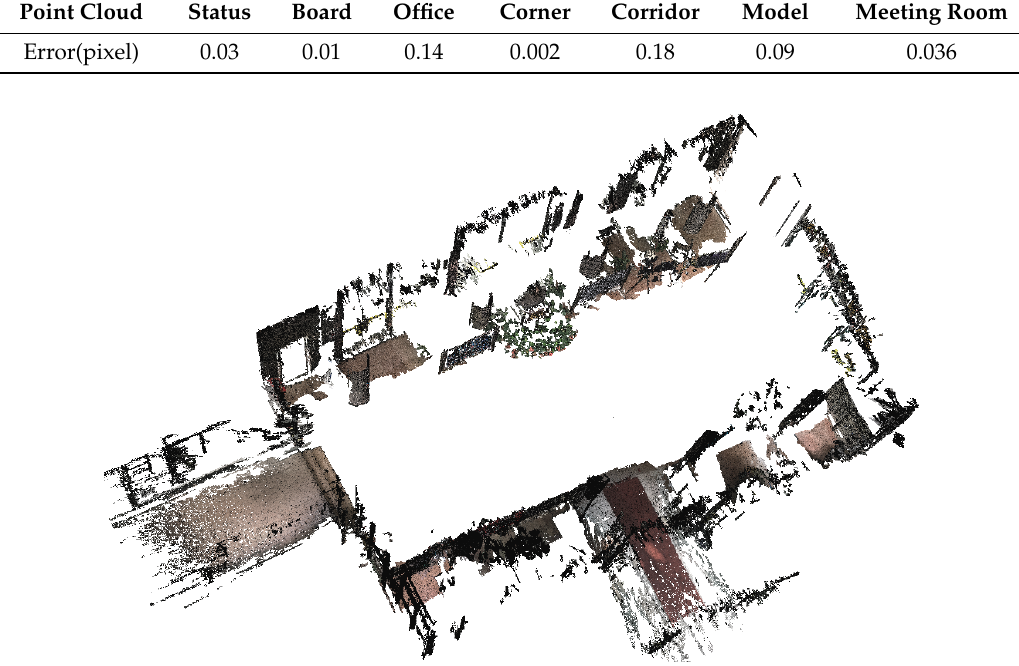
Figure 6 . The reconstructed model of the lobby dataset. Figure 6. The reconstructed model of the lobby Table 6. The registration error for the lobby dataset.